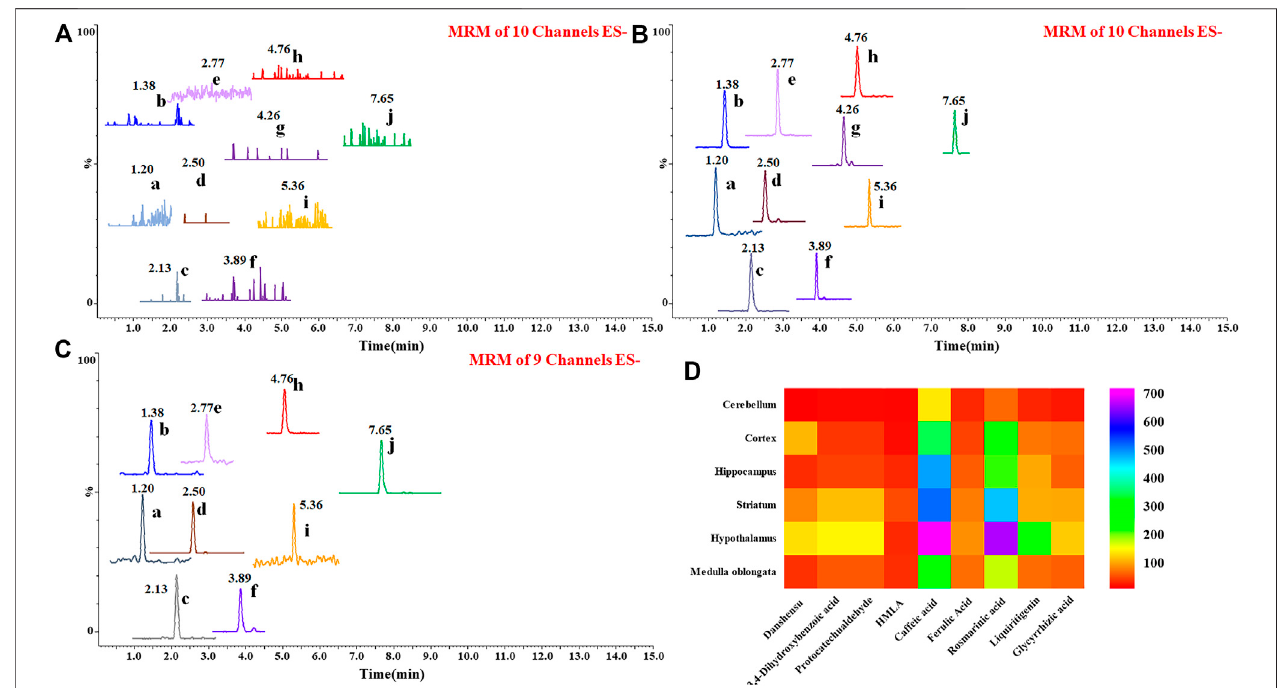
FIGURE 5 | Chromatograms of 10 prototype compounds detected in blank plasma (A) , plasma (B) , and brain tissues after the last administration (C) . No endogenous interference was found in the blank matrix, 10 known compounds were accurately identi fi ed as being absorbed into the blood, and 9 compounds were accurately identi fi ed as being absorbed into the brain. 1) Danshensu, 2) 3,4-dihydroxybenzoic acid, 3) protocatechualdehyde, 4) HMLA, 5) caffeic acid, 6) ferulic acid, 7) salvia fl aside,8)rosmarinicacid,9)liquiritigenin,and10)glycyrrhizicacid.Heatmapofrelative contentof9prototypedrugsinShuangxiadecoctionindifferentbrain regionsofrats (D) ,androsmarinicacidmainlyaccumulatesinthehypothalamus,followedbythestriatum.Caffeicacidismainlydistributedinthehypothalamus,striatum, and hippocampus.